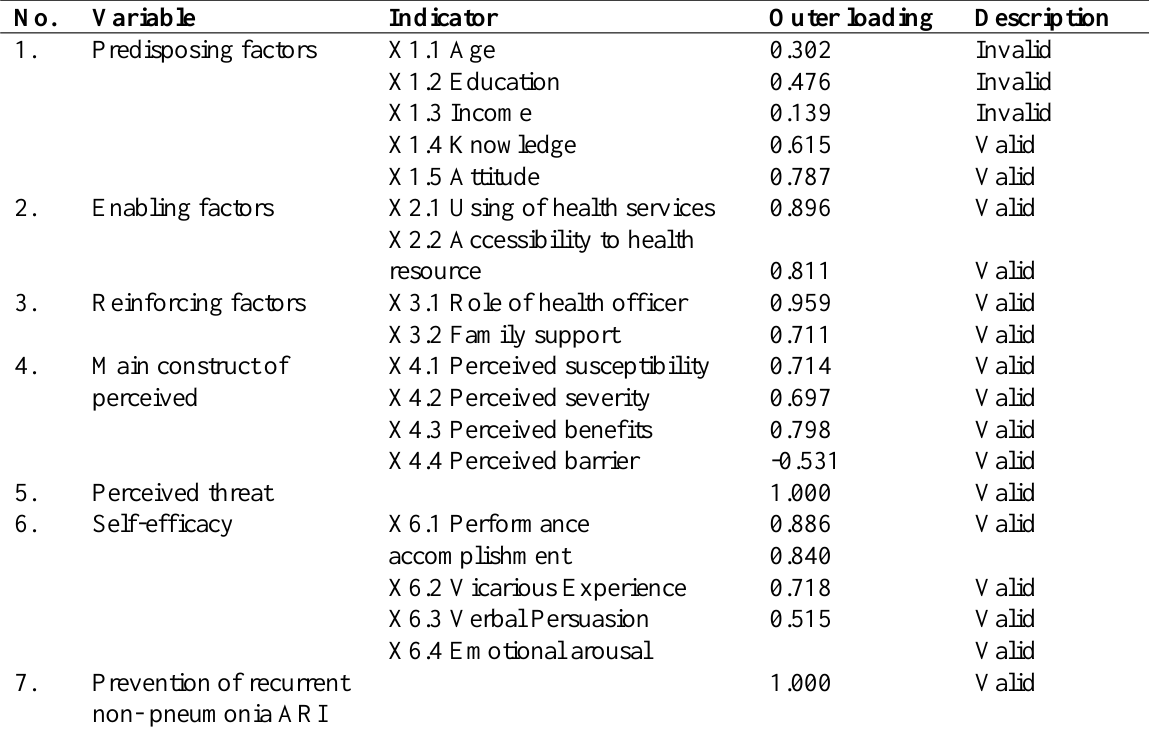
Table 1. Validity test results development of model on mothers self-efficacy in preventing recurrence of non-pneumonia acute respiratory infection among toddler in Tanggalrejo Village No.